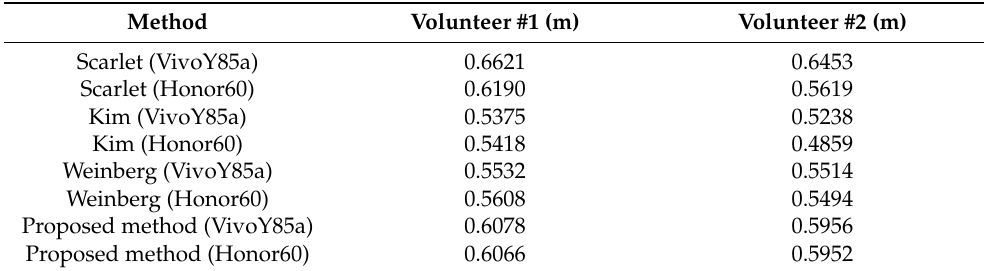
Table 2. Step length estimation with Honor60, VivoY85a, and two different height pedestrians in the first